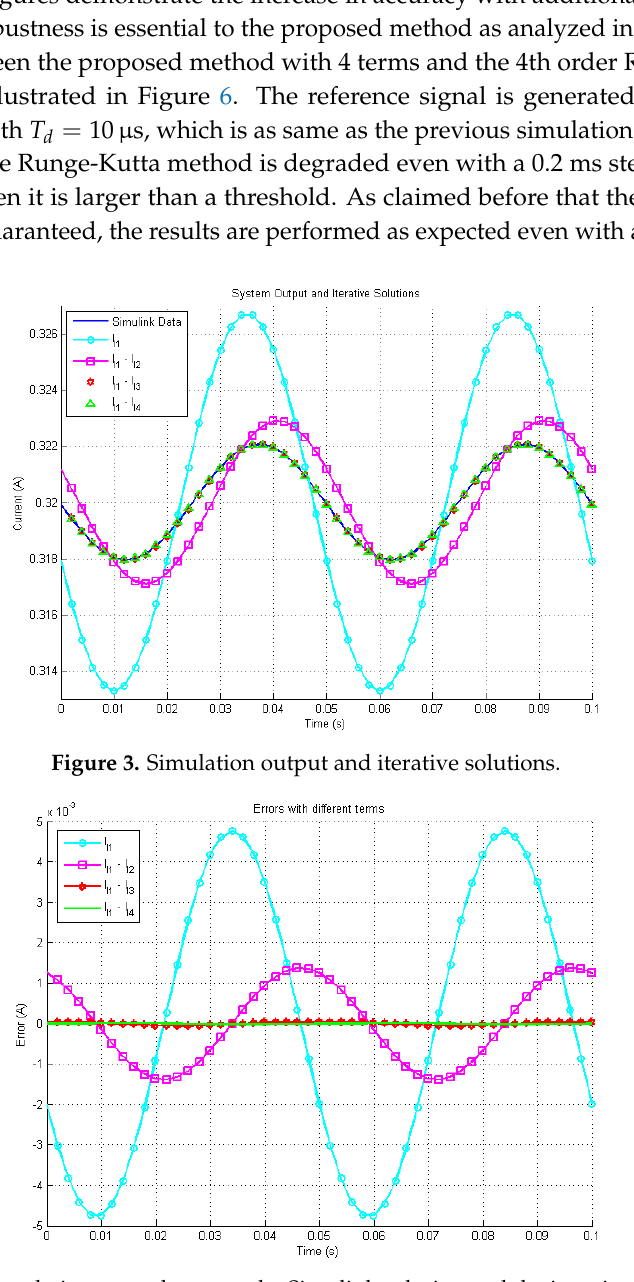
Figure 4. Simulation errors between the Simulink solution and the iterative